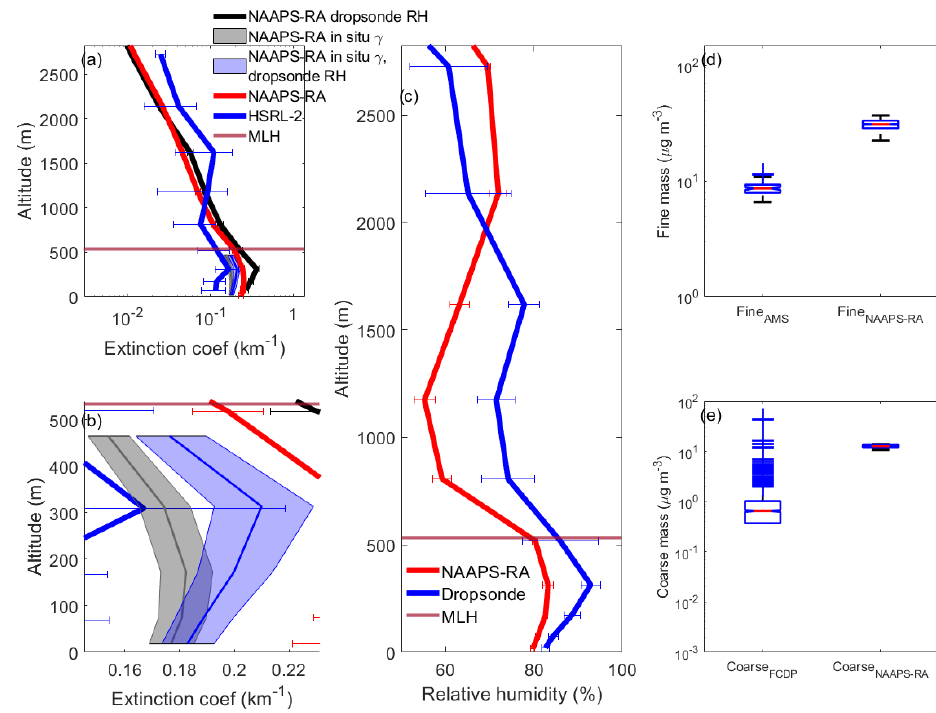
Figure 10. Same as Fig. 7 except for Case IV (RF17) on 1 October 2019. The MLH is 535m.